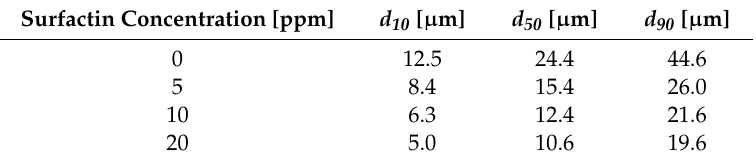
Table 1. Median diameter ( d 50 ), lower ( d 10 ) and upper ( d 90 ) deciles of calcium carbonate particles obtained in the presence of biosurfactant after 24 h of ageing. (Standard deviation for d values was lower than 1 µ ).